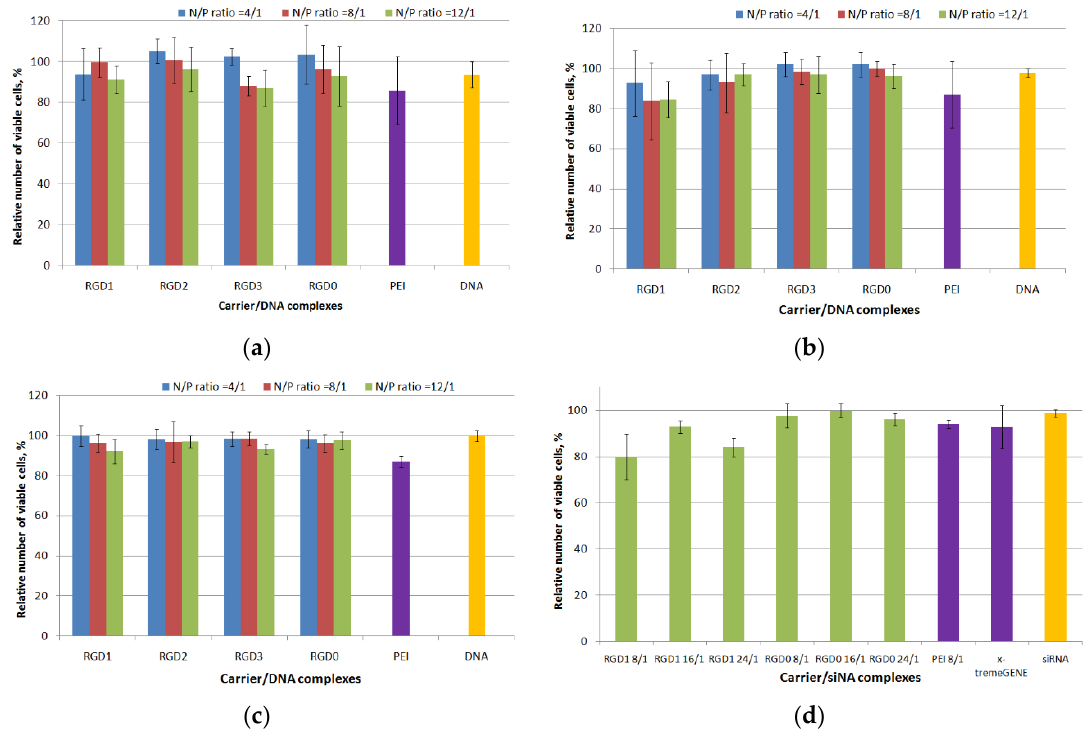
Figure 6. Cytotoxicity evaluation of carrier/DNA complexes in human pancreatic (PANC)-1 ( a ), human cervical carcinoma (HeLa) ( b ) and human kidney (293T) ( c ) cells and carrier/siRNA complexes in MDA-MB-231 ( d ) cells by the Alamar blue assay. Values are the mean ± SD of the mean of triplicateexperiments.